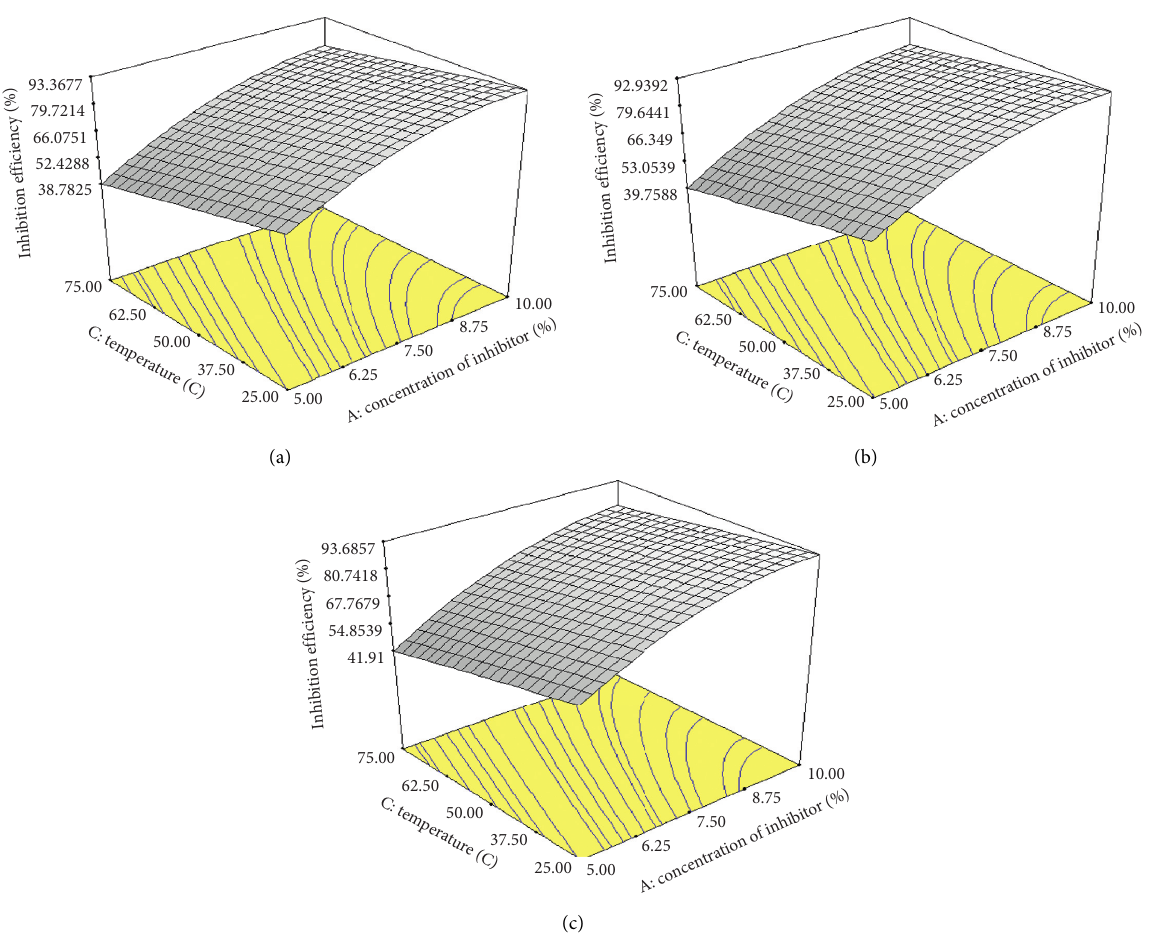
Figure 18: 3D plot of inhibition efficiency as a function of inhibitor load and temperature at rotation speeds (a) 250rpm, (b) 200rpm, and (c) Table 5. The absolute softness ( σ ) and hardness ( η ) are